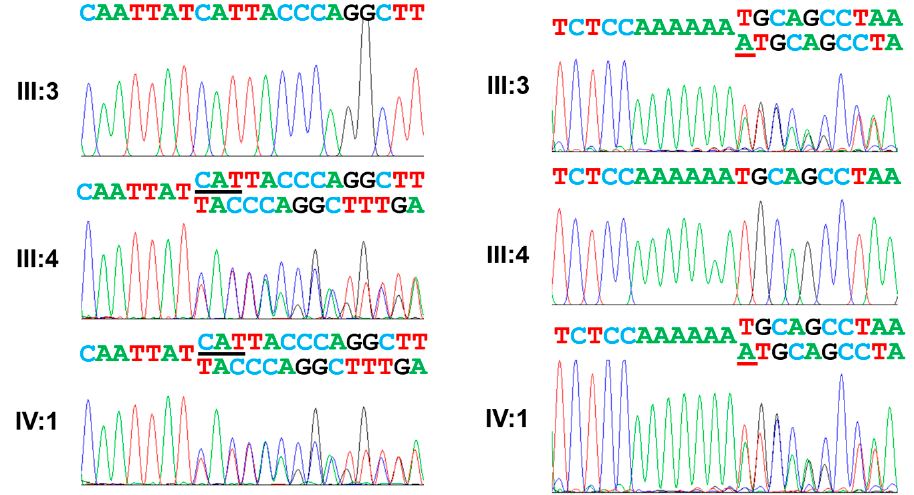
Figure 6. Sequencing chromatograms. The left side shows the maternal mutation (c.1287_1289del, p.(Ile430del)). Deleted nucleotides are indicated by black underline. The right side shows the paternal mutation (c.2332dupA, p.(Met778Asnfs*4)) with the duplicated nucleotide indicated by a red